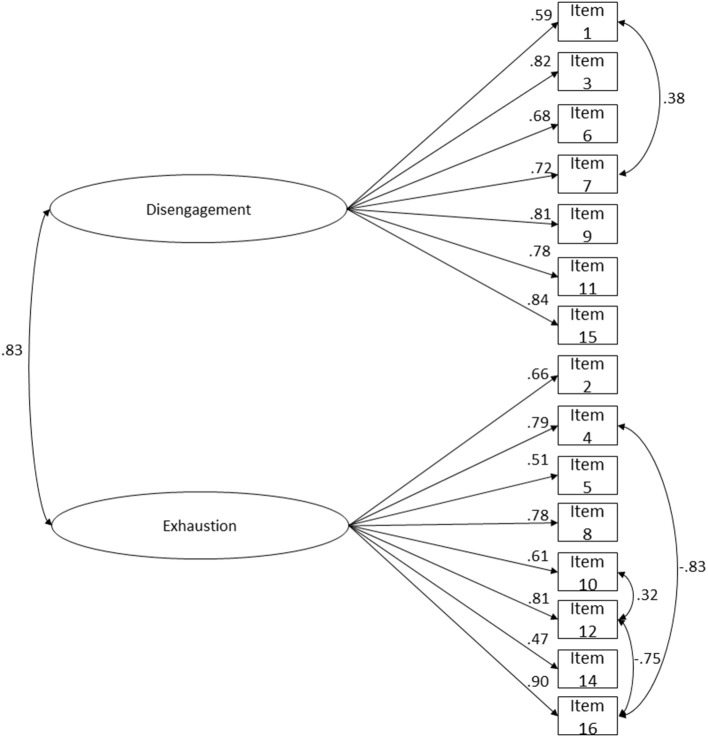
OLBI's two-factor reduced version (15-item) structure fit. A combined sample of Portuguese (n = 268) and Brazilian (n = 318) workers. Correlations between latent variables, residuals' correlations and factor loadings for each item are shown. χ(85)2 = 514.098; p < 0.001; n = 586; CFI = 0.986; CFIscaled = 0.937; NFI = 0.984; TLI = 0.983; SRMR = 0.064; RMSEA = 0.093; P(rmsea ≤ 0.05) < 0.001; 90% CI ]0.085; 0.101[.